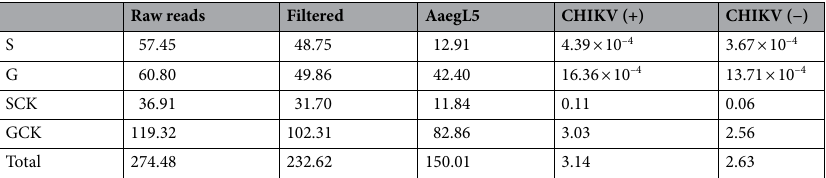
Table 1. Small RNA deep sequencing and mapping. Numbers indicate million reads. Filtered, reads remaining after adapter removal and size selection (≥ 14). Reads mapping to the Ae. aegypti genome (AaegL5) and to the chikungunya virus (CHIKV) genome (+) and antigenome (−) are